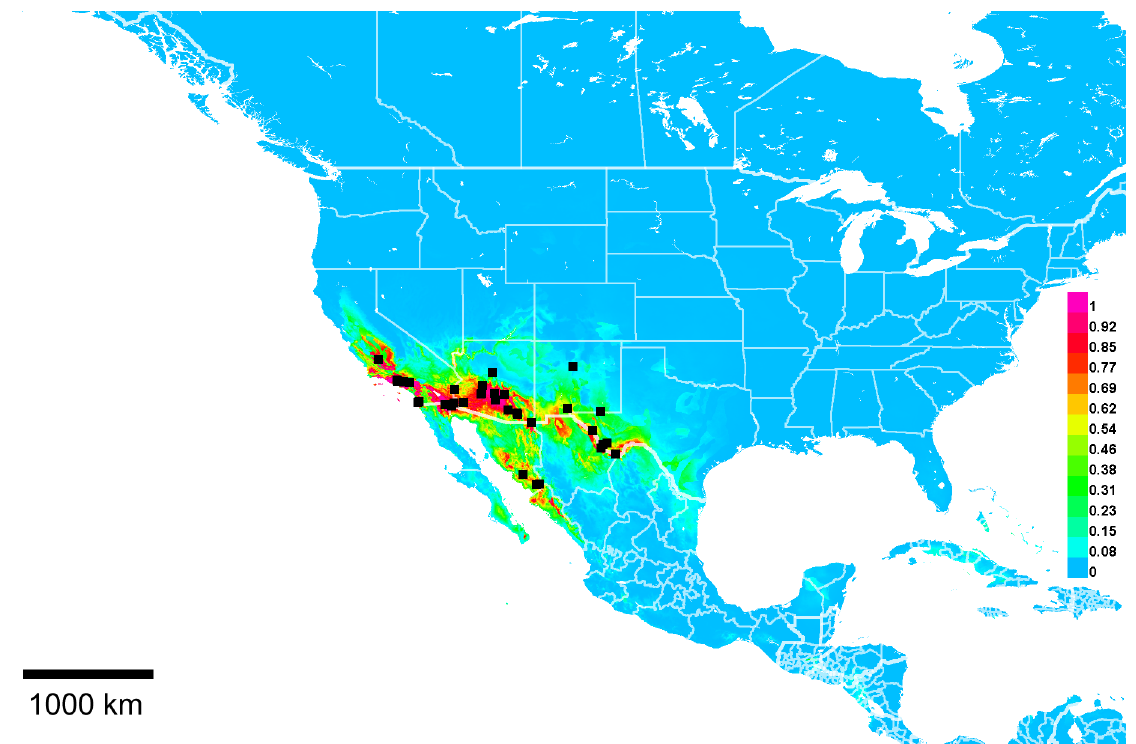
Fig. 47. Georeferenced collection records of Lasioglossum ( D .) perparvum (Ellis, 1914) (black squares) and predicted distribution by maximum entropy ecological niche modelling in Maxent (colour shading). Warmer colours indicate higher cloglog probability of